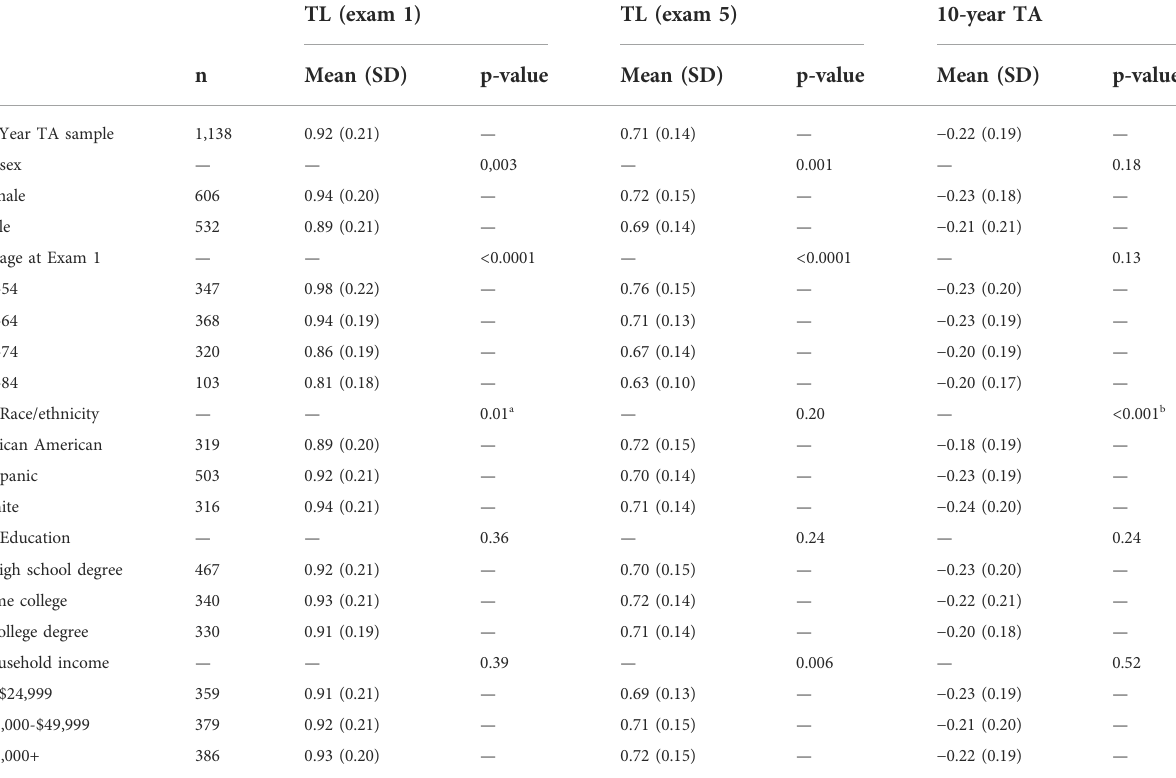
TABLE 3 Mean Telomere Length (TL, T/S Ratio) and 10-year Telomere Attrition (10-year TA) for the Full Sample and by demographics.